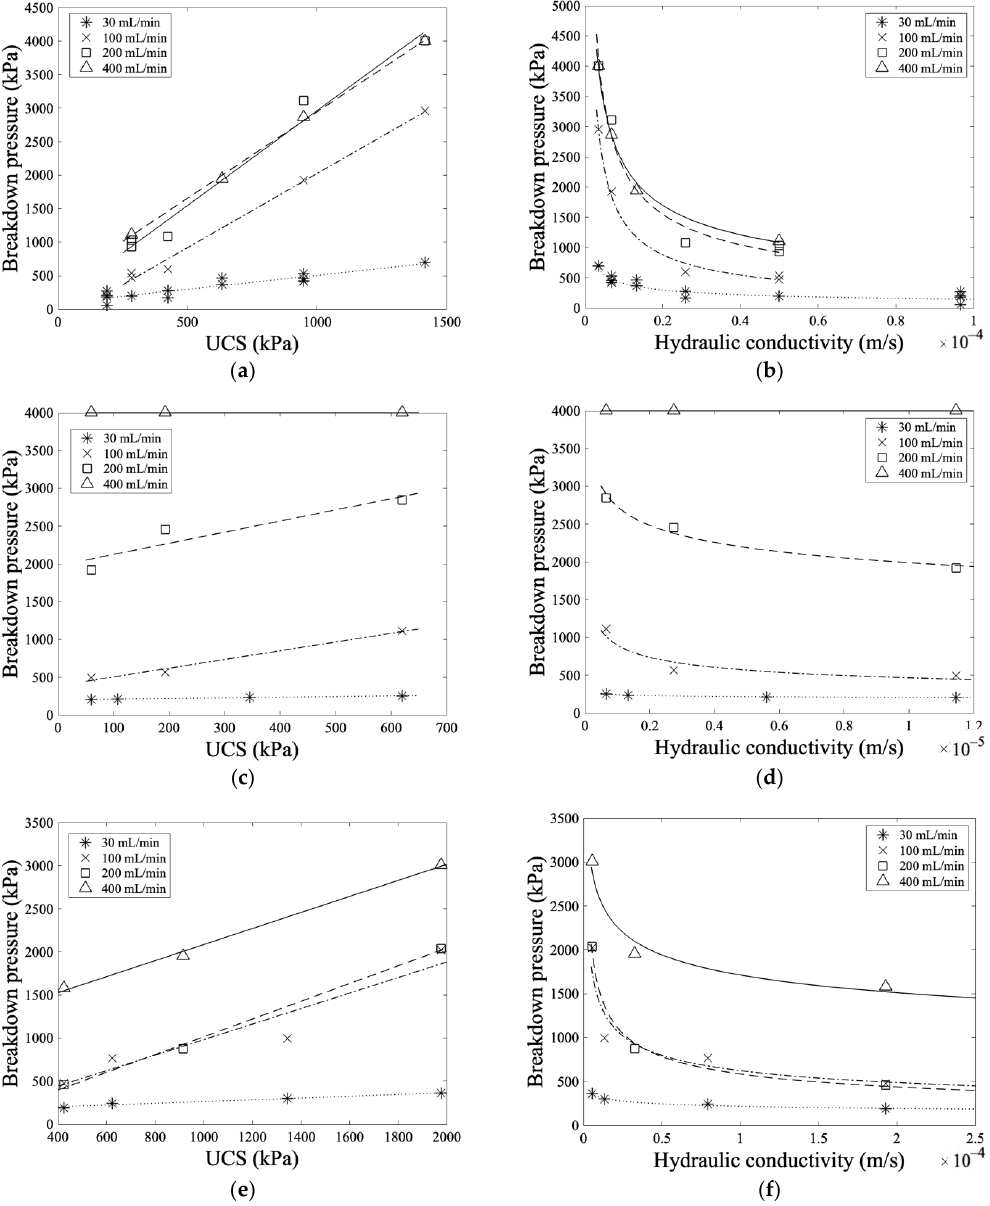
Figure 11. Correlations of breakdown pressures obtained during fluid injection experiments in bio- cemented sands at various flow rates with respect to ( a , c , e ) UCS and ( b , d , f ) Hydraulic conductivity. ( a , b ) refer to fine sands, ( c , d ) refer to glass beads, and ( e , f ) refer to medium-grained sands. The fits of the breakdown pressure and hydraulic conductivity are in a power form (Figure 11b). Very small changes in the breakdown pressures were induced when the in- jection rate was at 30 mL/min. As the flow rates increased, the exponential relationship between breakdown pressure and hydraulic conductivity became more distinct. The dif- ferences were also evident in the fracture patterns. Since hydraulic conductivity and po- rosity for the same base material are controlled by the overall amount of cementation